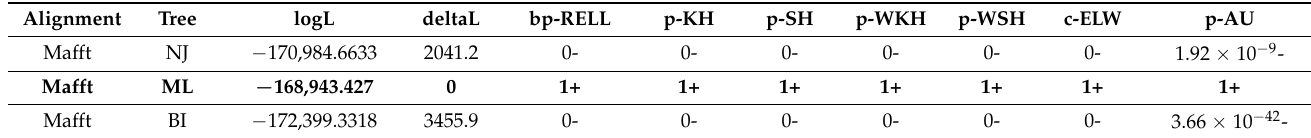
Table 2. Topology comparison for phylogenetic methods for the RdRp gene of PBVs using all 403 complete gene sequences available at the GenBank database. (Best topology detected is highlighted in bold).